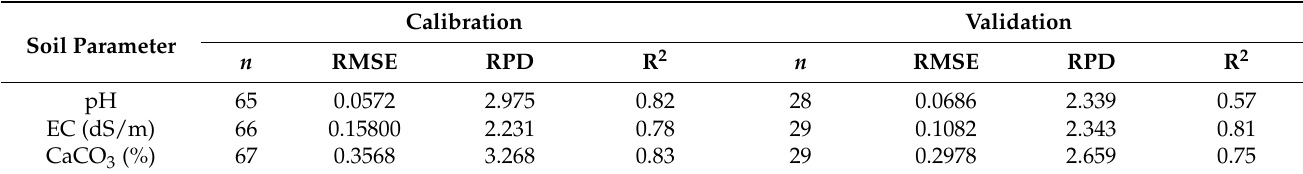
Table 8. The obtained data of RF models for each soil parameter.